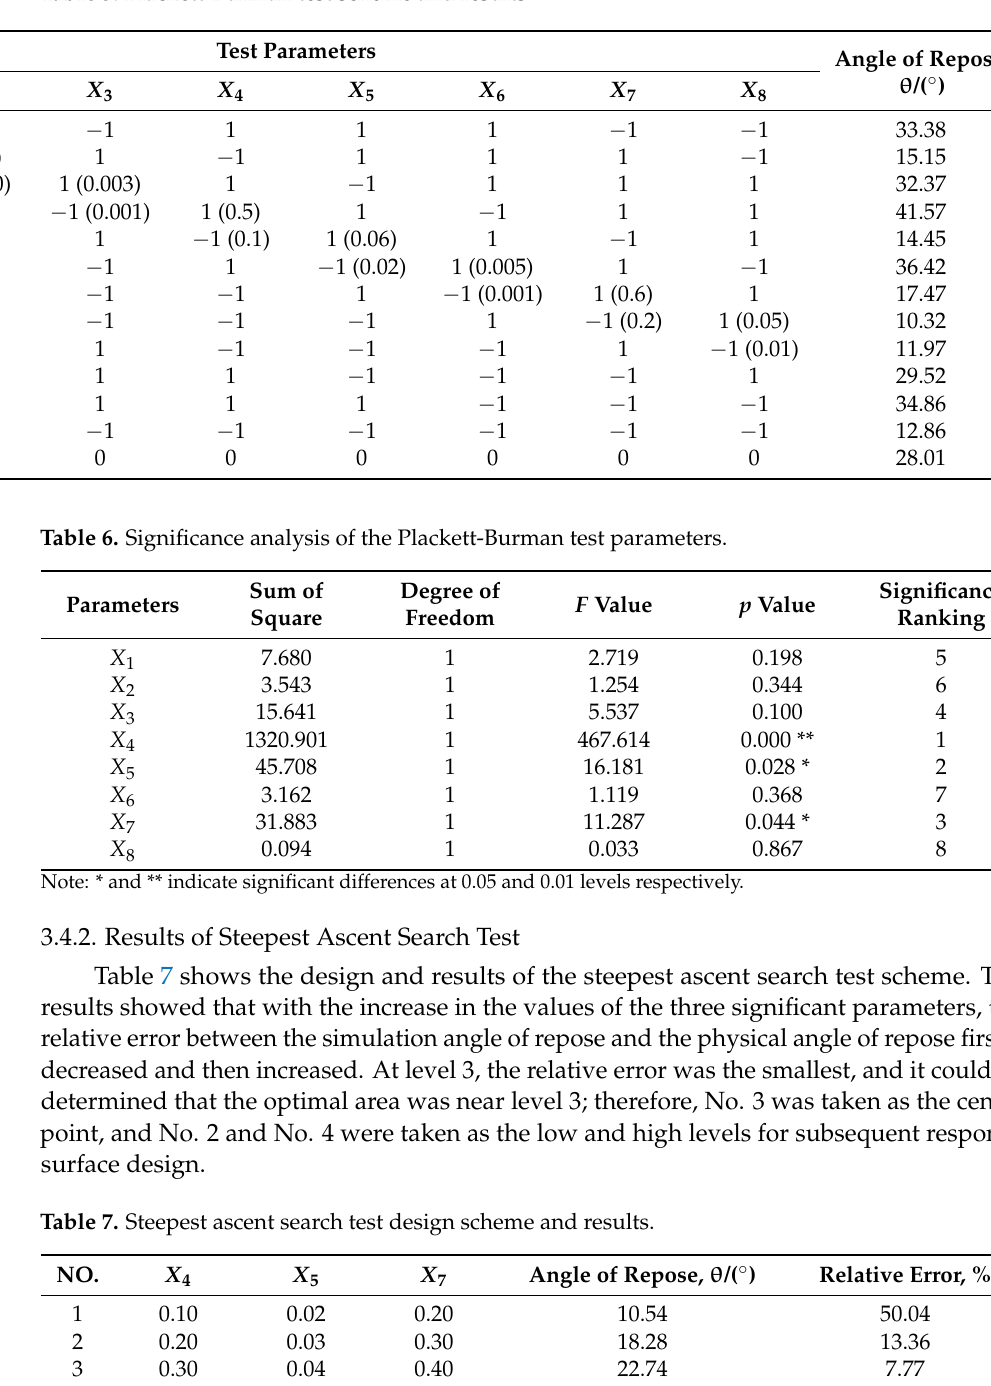
Table 5. Plackett-Burman test scheme and results.